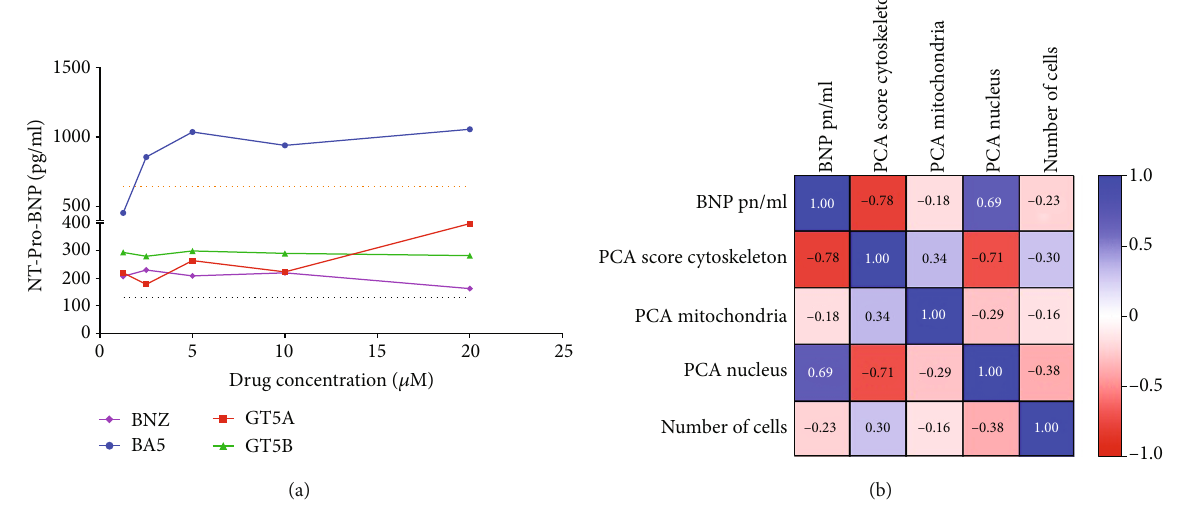
Figure 5: NT-pro-BNP analysis and correlations with morphology parameters. (a) NT-pro-BNP levels in the culture supernatant 48h following treatment with the compounds in di ff erent concentrations. Dash lines represent NT-pro-BNP levels in the culture supernatant of untreated hiPSC-CMs (black) 48h following treatment with endothelin-1 (orange). (b) Correlation matrix heat map demonstrating R values found for each comparison between the di ff erent variables. Table 2: Correlations between NT-pro-BNP levels and morphological parameters. PCA mitochondria